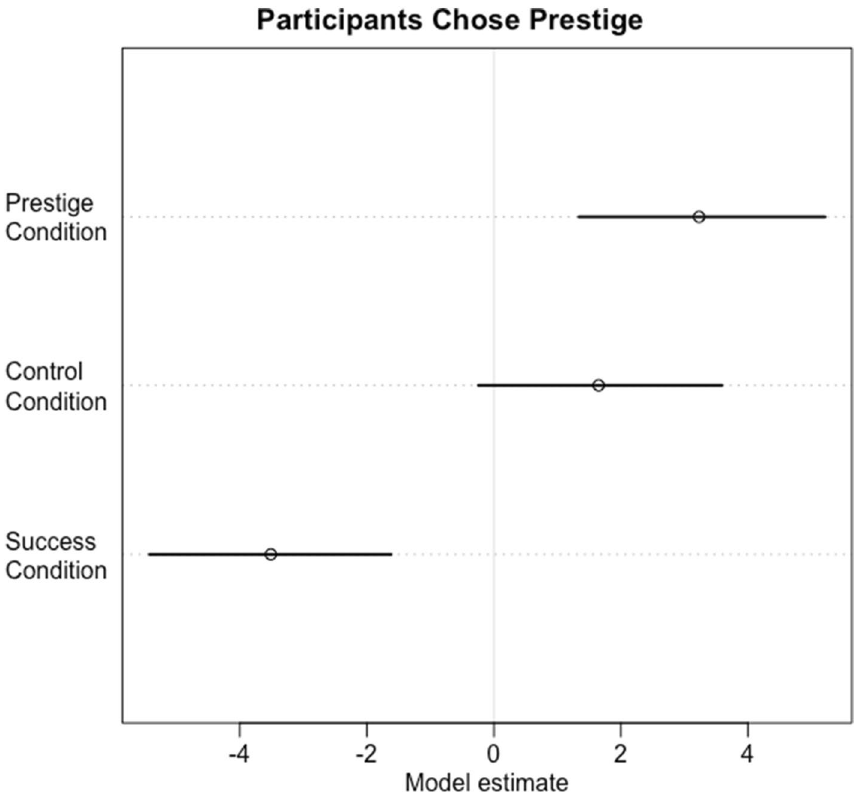
Figure 3. Model estimates for choosing prestige information (number of times demonstrators were copied in Round 1) compared to the alternative information in Round 2 of the Prestige, Control and Success Conditions. The alternative information for the Control and Prestige Conditions was irrelevant Player ID, and the alternative information for the Success Condition was success (score in the quiz). Participants therefore only reliably chose prestige when it was based on relevant information, and when success was not